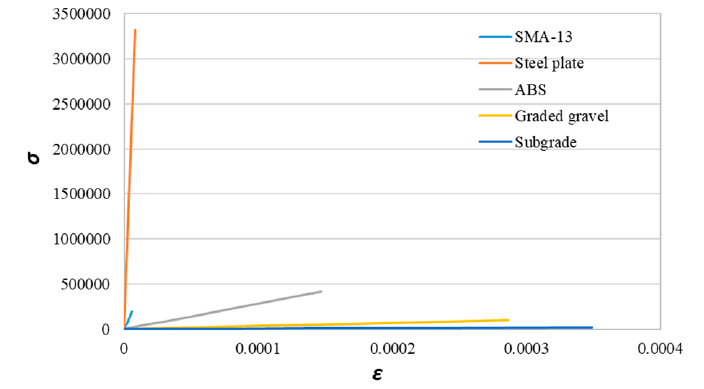
Figure 4. Stress–strain response of each material.